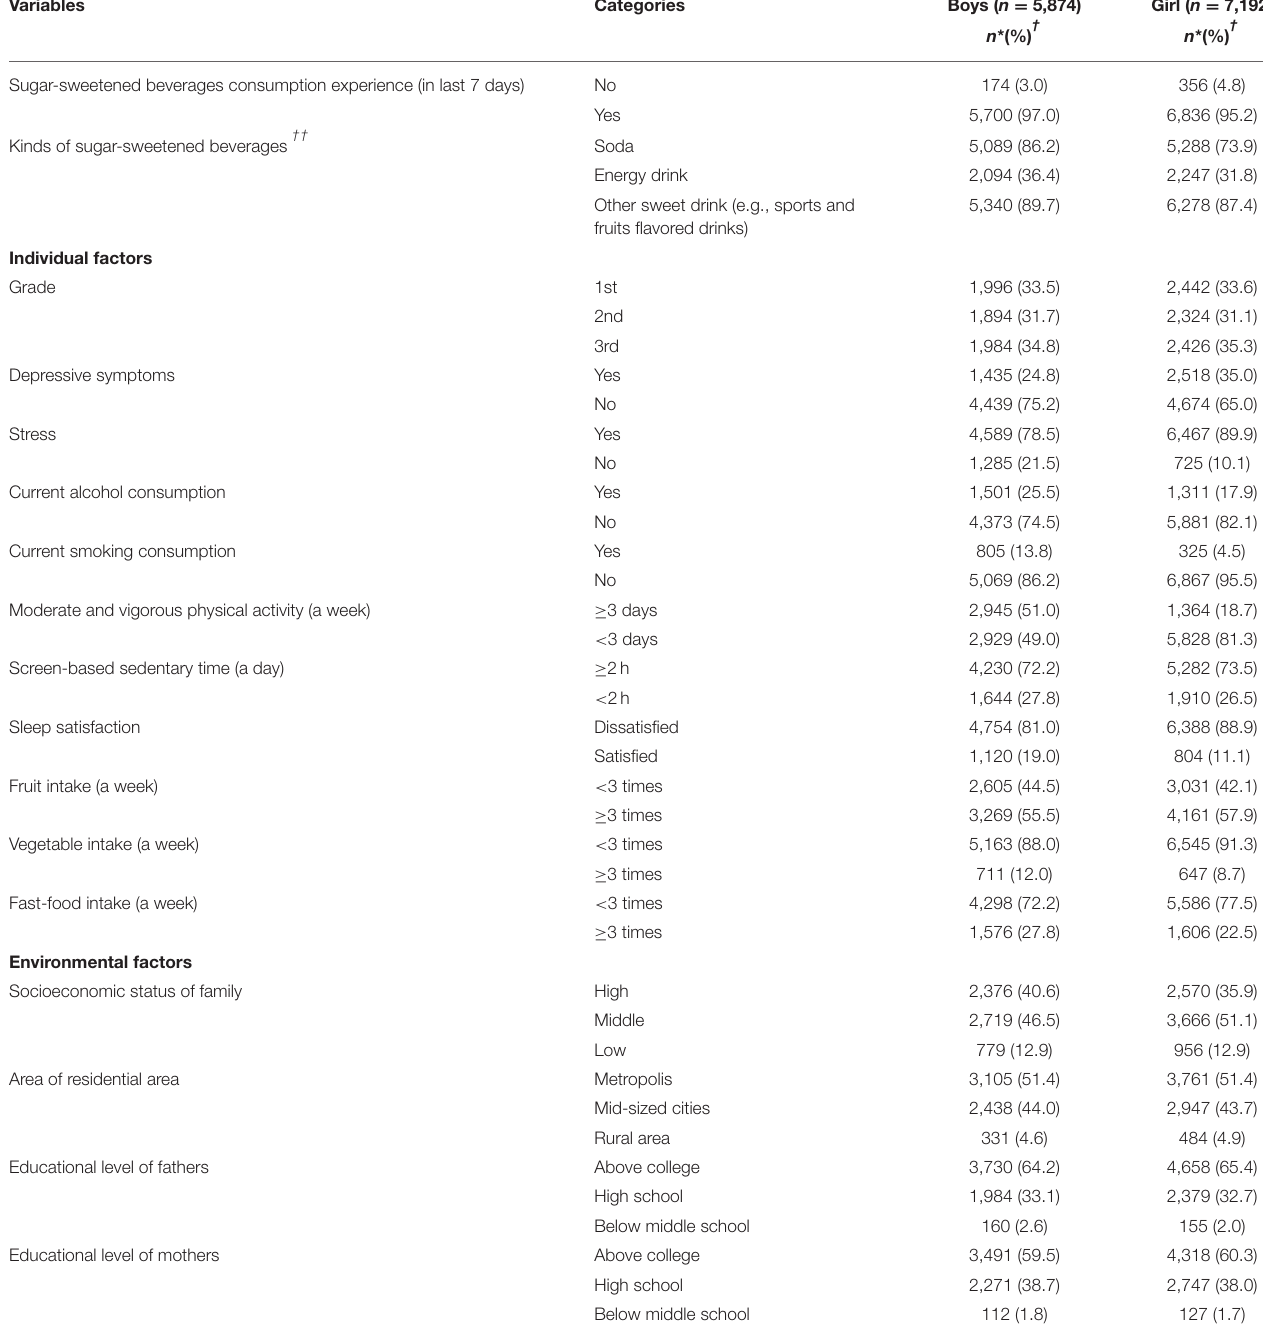
TABLE 2 | Characteristics of sugar-sweetened beverages and individual and environmental factors among